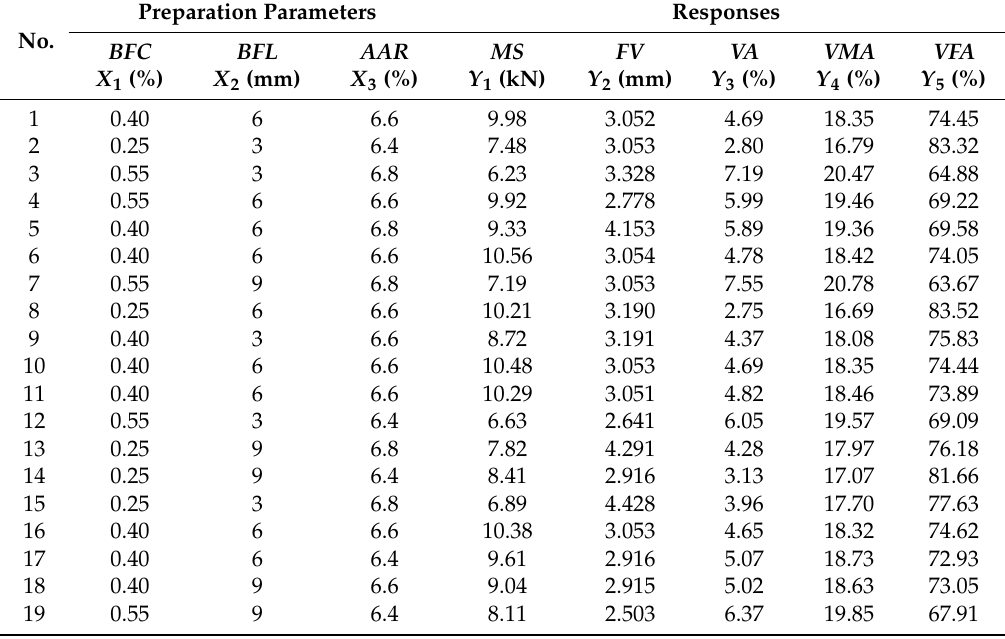
Table 5. Experimental design and test outcomes by face-centered central composite design